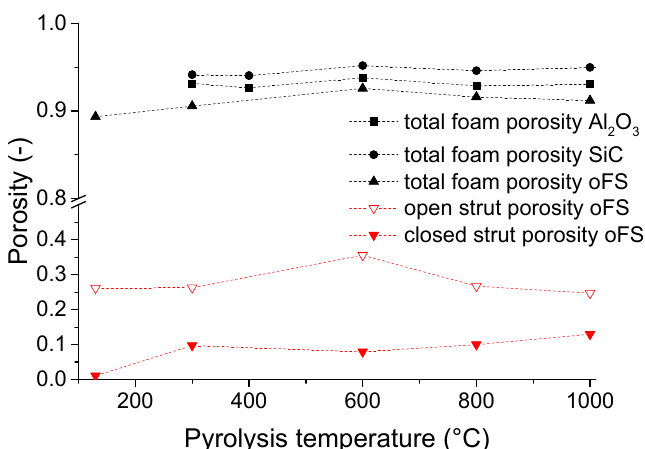
Figure 5. Geometrical foam porosity from the filler-free and filler-loaded samples and open and closed